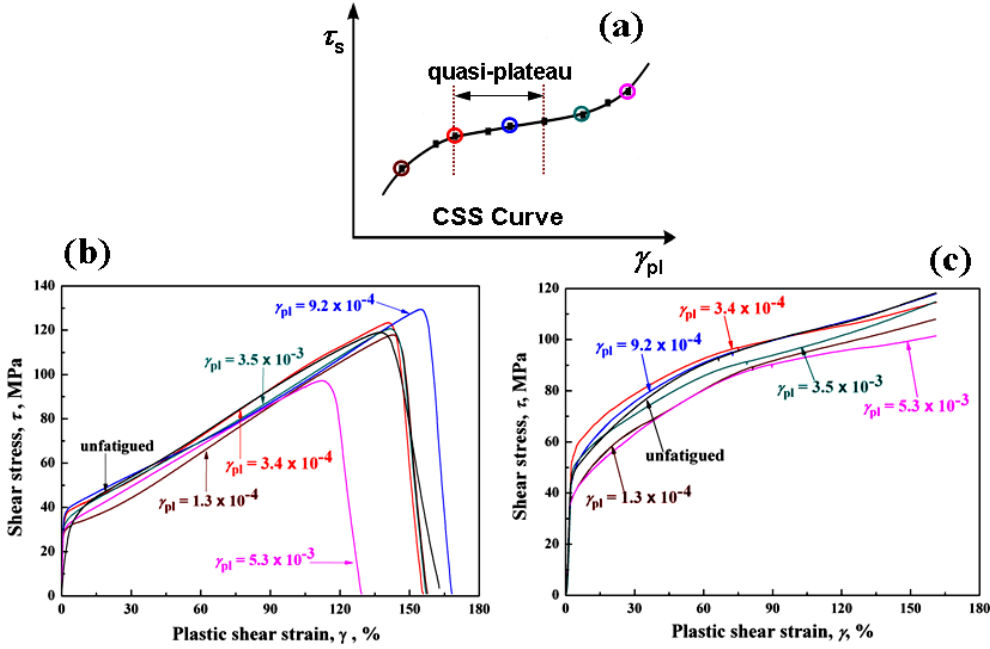
Figure 1. ( a ) CSS curve of ]332[ Cu single crystals [10]; ( b ) the tensile and ( c ) compressive stress-strain curves of ]332[ Cu single crystals unfatigued and pre-fatigued at different plastic strain